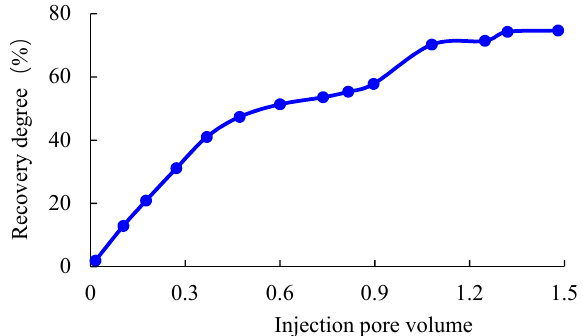
Figure 12. The relationship between injected pore volume and recovery degree of 0.98 mD core.